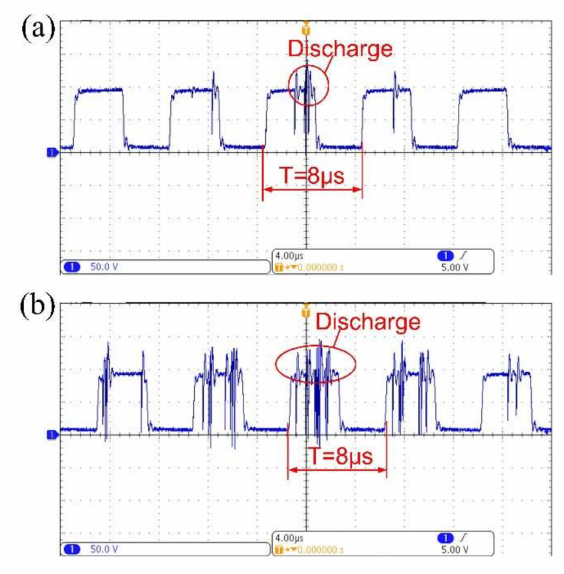
Figure 5. Discharge voltage waveform comparison: ( a ) without and ( b ) with the addition of TiC powder (5 g /